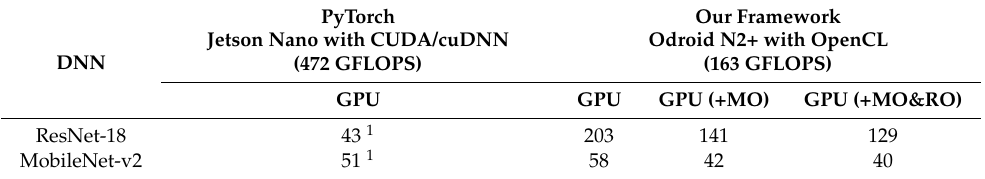
Table 8. Comparison of inference times (ms) of PyTorch and our framework.